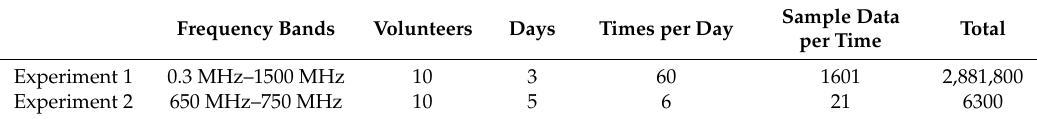
Table 2. Experimental setup.